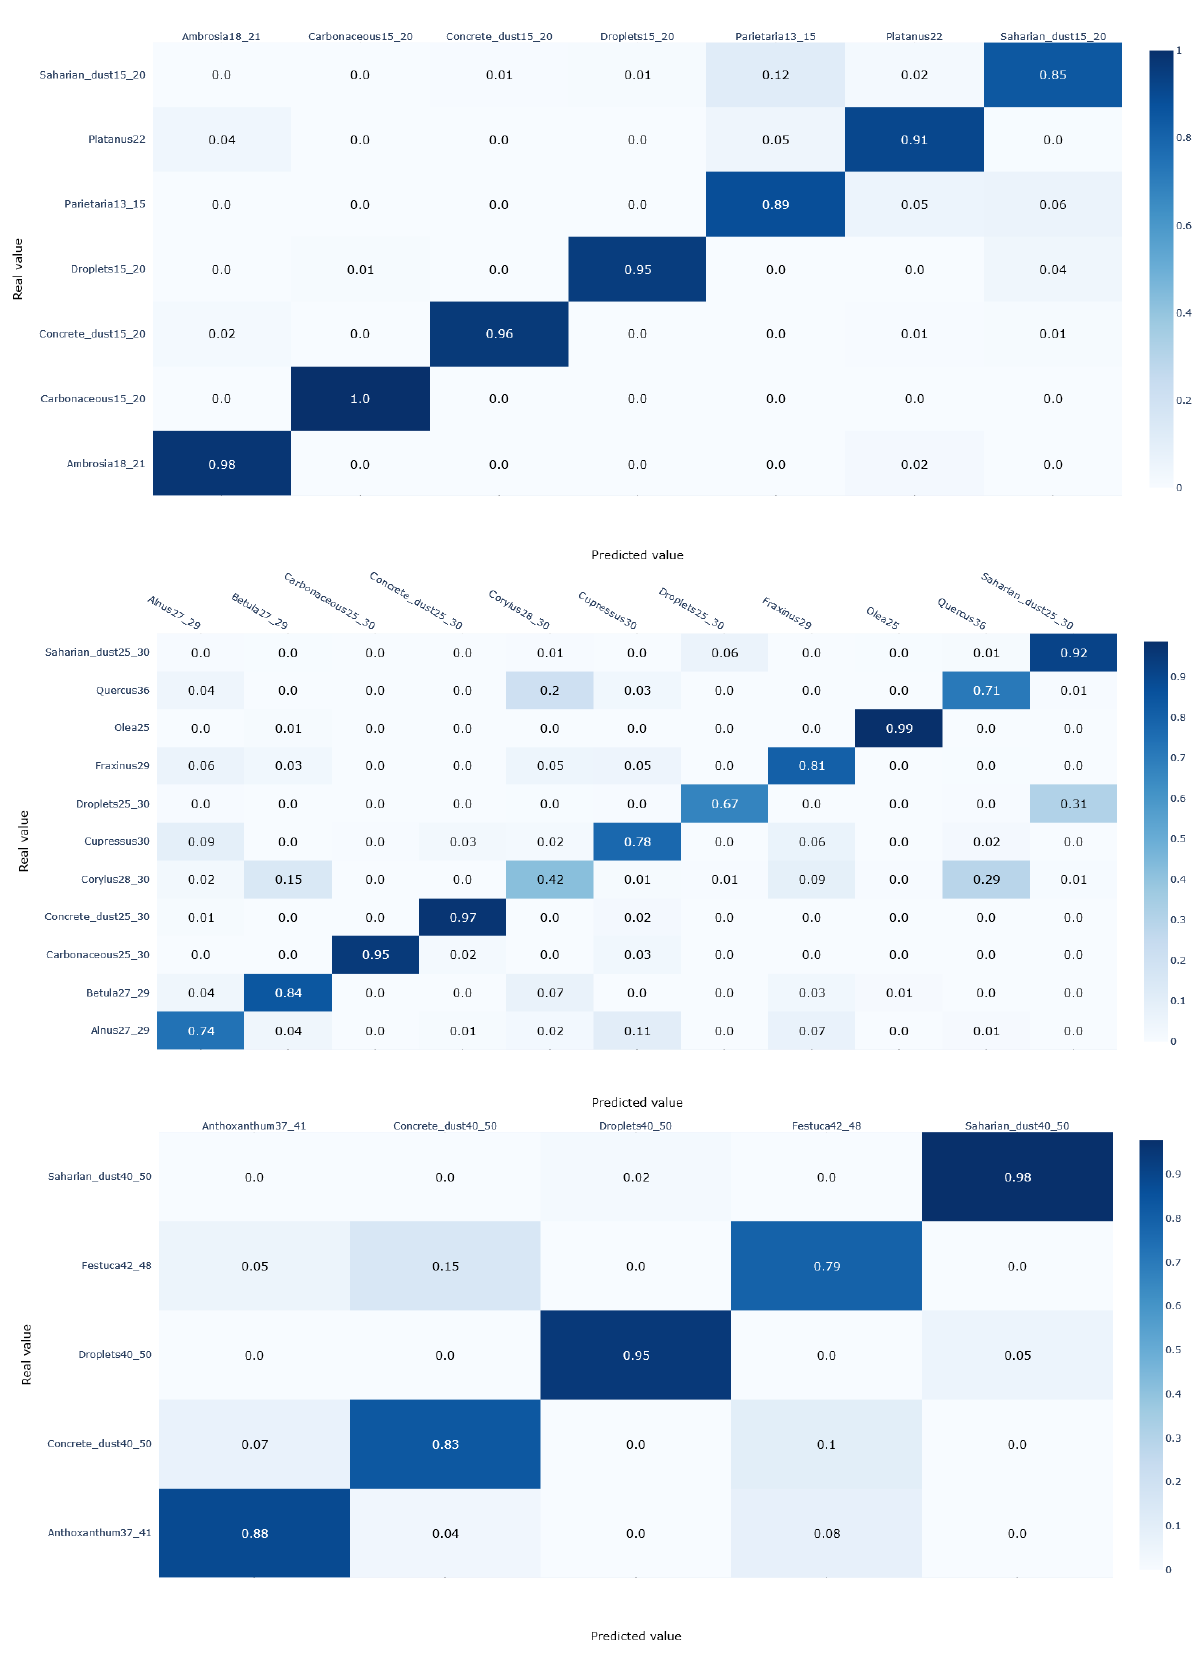
Figure 7. Confusion matrices of the predictions obtained by the logistic regression trained on the optical signatures of species that belong to the same size cluster.